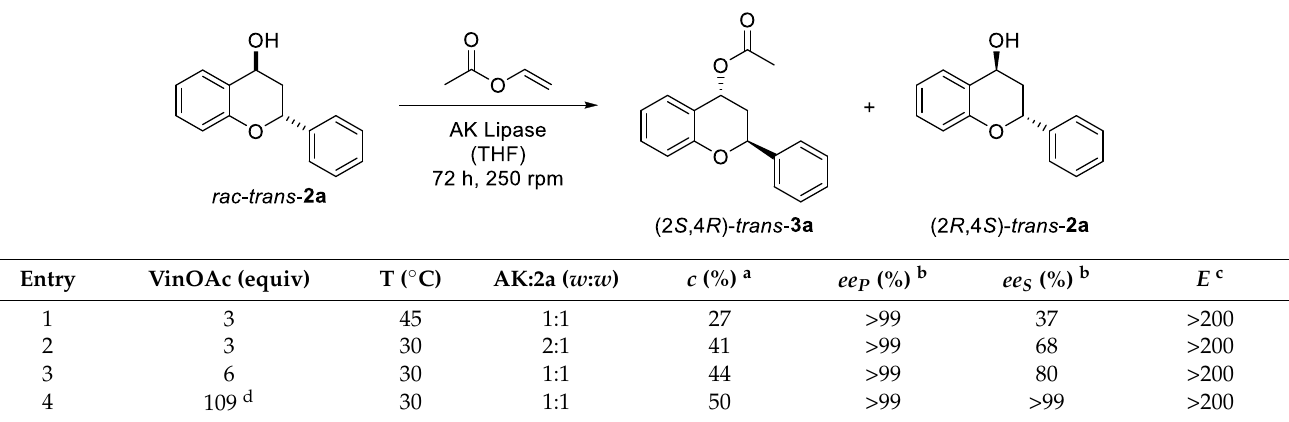
Table 4. Optimization of the AK lipase-catalyzed kinetic resolution of trans - 2a by acetylation using vinyl acetate (VinOAc).